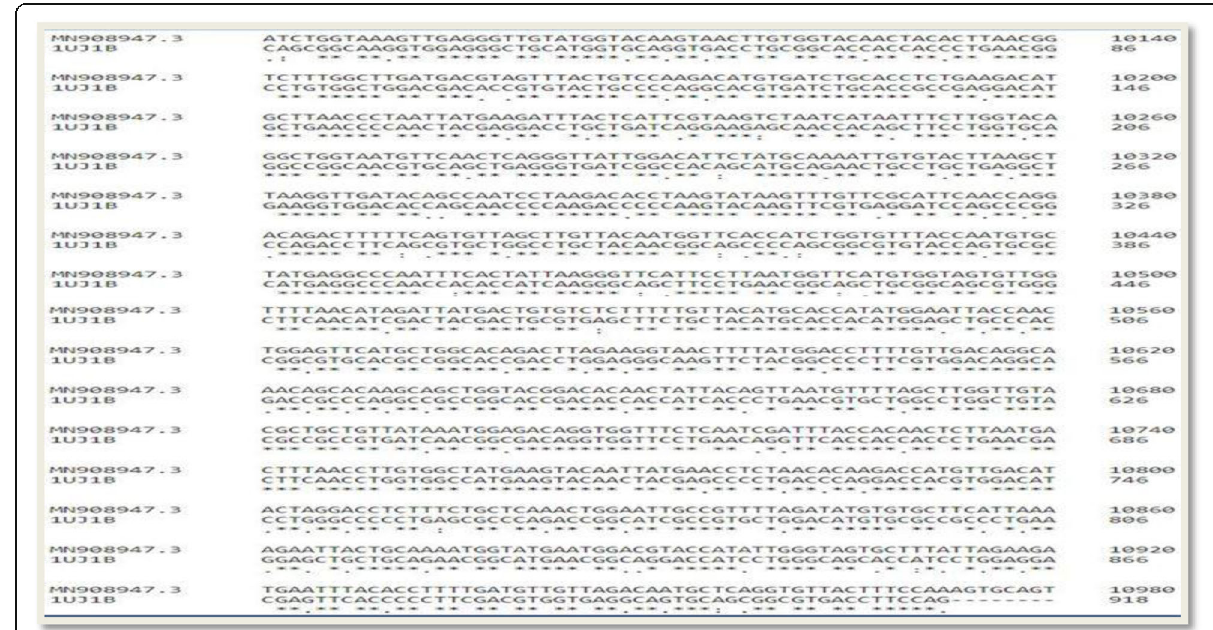
Fig. 5 Sequence alignment between the nucleotide sequence of the back-translated SARS coronavirus main proteinase and the 10055 to 10972 nucleotide region of the 2019-nCoV complete genome